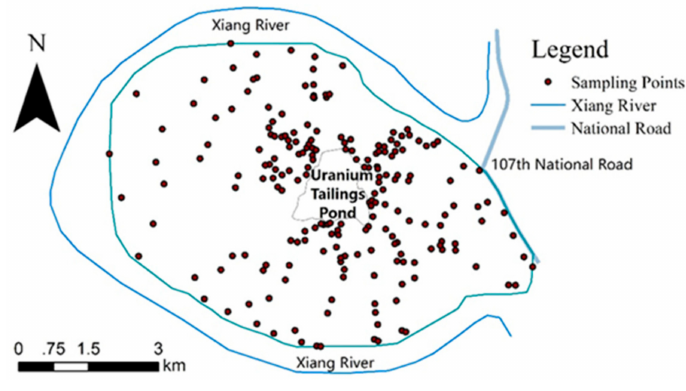
Figure 1. The study